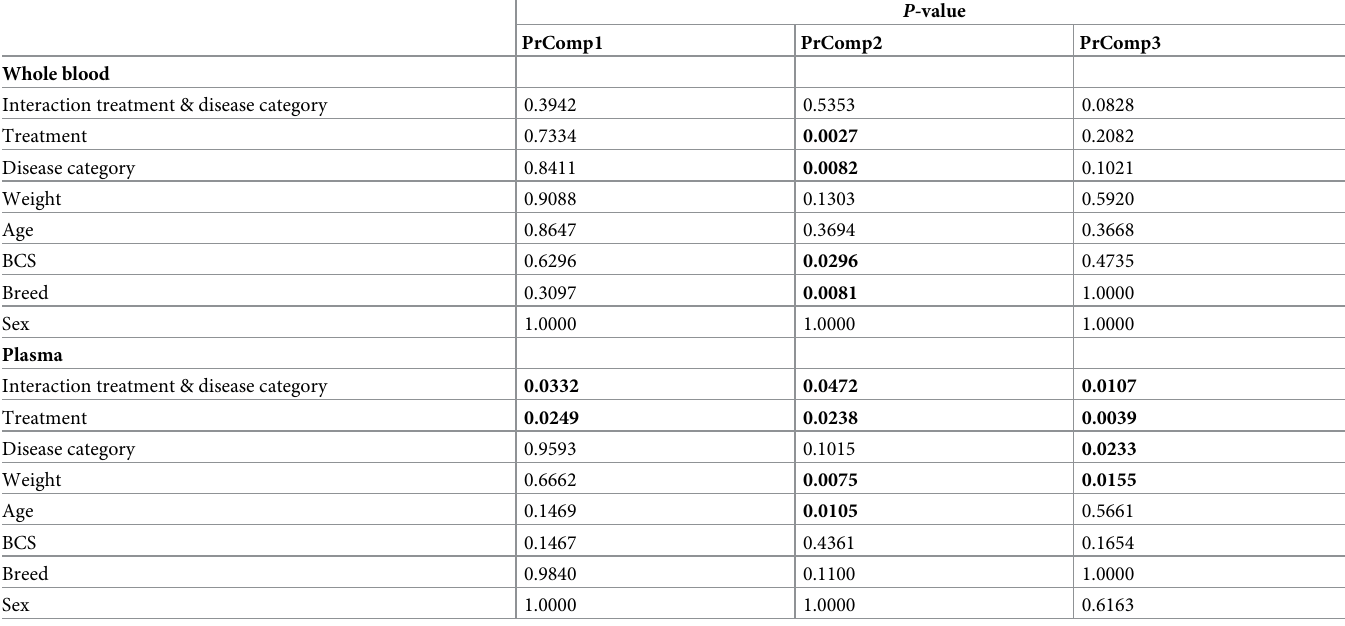
Fig 1. Principal component analysis (PCA) of the phospholipid profile in plasma and whole blood samples. In the score plot (left panel) each dot represents one analyzed sample and similar phospholipid profiles cluster together. A clear separation between plasma and blood samples is observed. In both types of specimen, the three disease categories are similarly positioned to each other, indicating a similar shift in the phospholipid profile in both sample types. Samples are color-coded by sample type and disease classification. The principal component loadings plot (right panel) visualizes the contribution of each phospholipid species to the total variance in the phospholipid profile, to which phospholipid species with the largest distance from the origin contributed the most. Each dot represents a different phospholipid species and the same color is used for the same phospholipid class. Dot sizes are proportional to the MS signal intensity of the phospholipid species. PrComp, principal component; PC, phosphatidylcholine; SM, sphingomyelin; PI, phosphatidylinositol. https://doi.org/10.1371/journal.pone.0215435.g001 initiation of treatment in these dogs. Significant differences were observed in the phospholipid profiles in dogs with CIE, especially between the two different types of specimen used (whole blood vs. plasma), disease category (IBD vs. FRD), and treatment status. An explanation for the distinct phospholipid profiles in whole blood and plasma samples as discovered by PCA could be the difference in the number of cells within these sample types. As lipids, including Table 2. Summary of ANOVA p -values of all evaluated